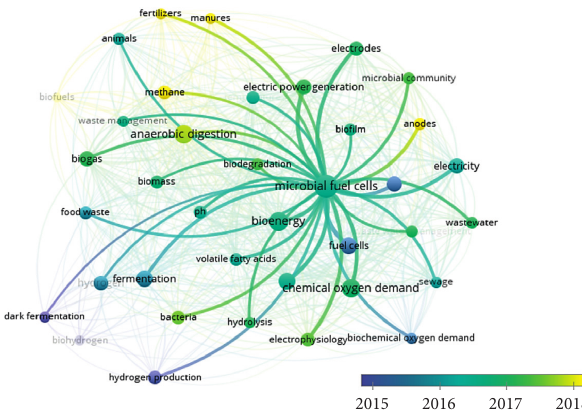
Figure 1: Scientometric chart